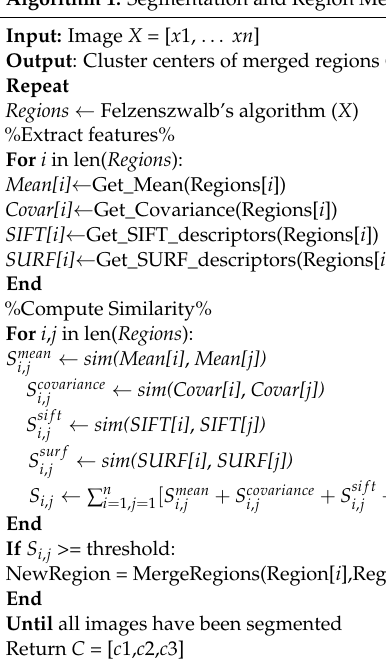
Figure 3. Image segmentation results on SYSU 3D HOI dataset, including ( a ) original image, ( b ) image segmentation, ( c ) merged regions, and ( d ) extracted silhouette. Algorithm 1: Segmentation and Region Merging